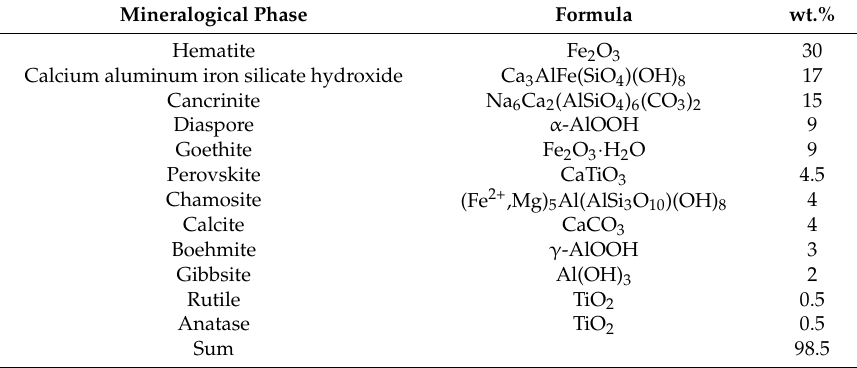
Table 2. Bauxite residue mineralogical phases and